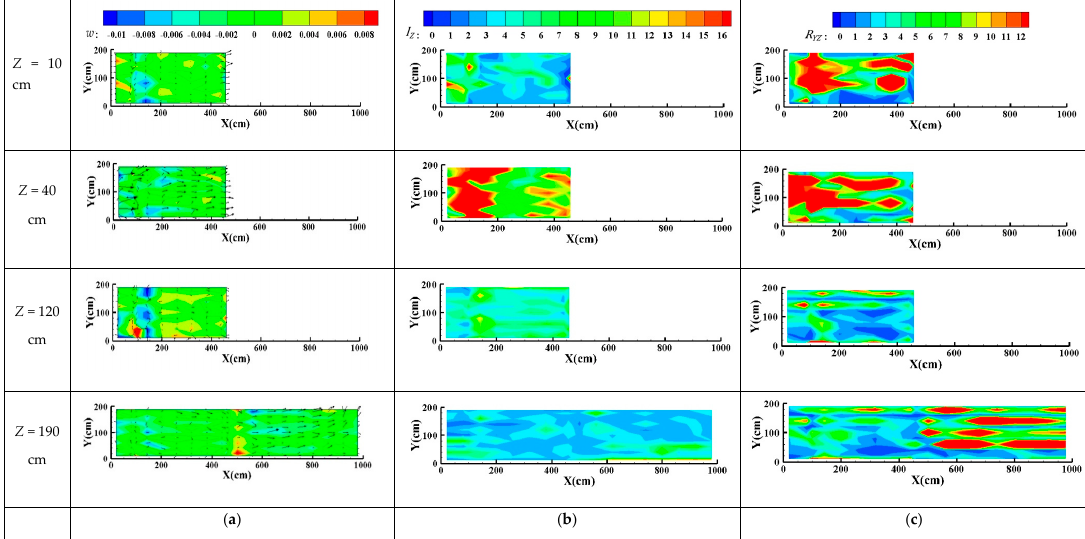
Figure 6. Distribution of vertical flow characteristics: ( a ) velocity (the contour plot represents the vertical velocity w , and the vector represents velocity u - v ); ( b ) dimensionless turbulence intensity 𝐼 (cid:3027) ; and ( c ) dimensionless Reynolds shear stress 𝑅 (cid:3026)(cid:3027) . (The unit of velocity is m/s, and the dimensionless turbulence intensity and dimensionless Reynolds shear stress is dimensionless).